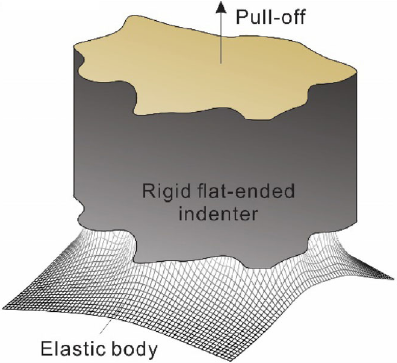
Fig. 1 We consider adhesive contacts of rigid indenters with flat but oddly shaped face with elastic